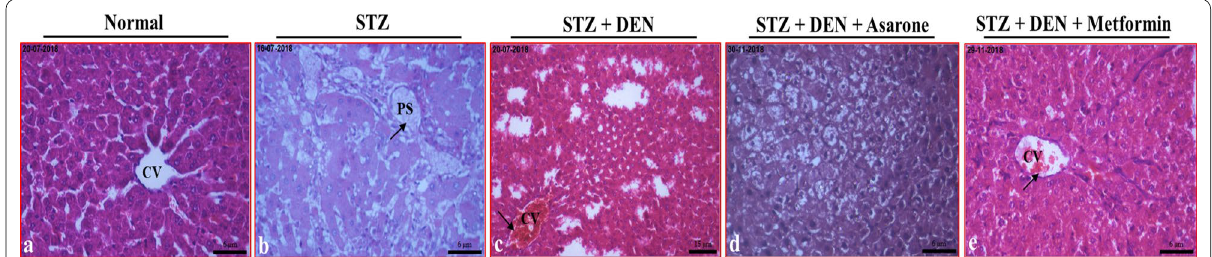
Fig. 3 Representative histological features of liver sections stained with hematoxylin–eosin (H and E) obtained from normal rats a , STZ-induced diabetic rats b , STZ DEN-induced diabetic HCC rats c , STZ + indicate congestion in CV and PS. ( a , b , d , e , magnification: 200; c , magnification: 100). STZ, streptozotocin; DEN, diethylnitrosamine; CV, central vein; PS, portal